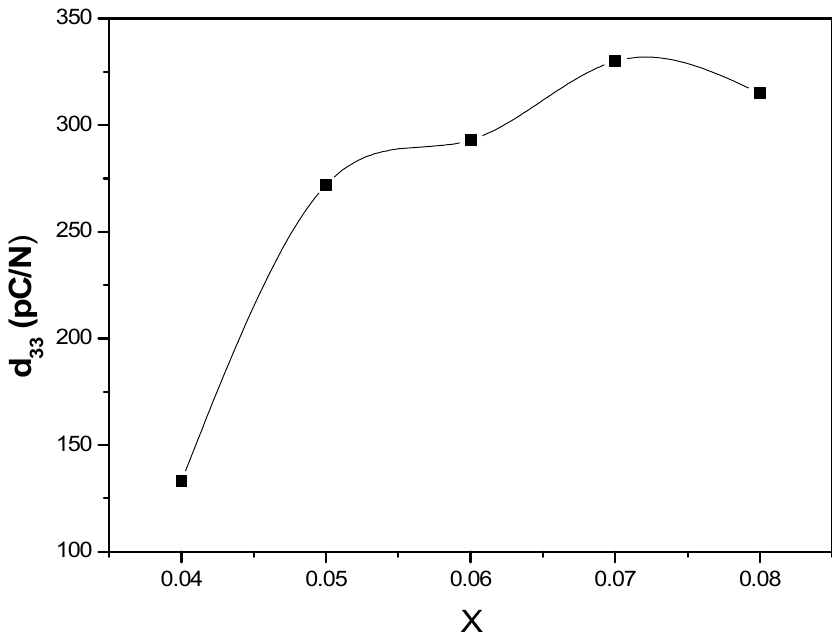
Figure 8. Piezoelectric constant (d33) of samples with the amount of antimony. The antimony content can enhance the sinterability of the samples together with the liquid phase formation of CuO and B 2 O 3 , resulting in enhancement of d 33 and ε r . The d 33 of x = 0.07 specimen with electric field shown in Figure 9.